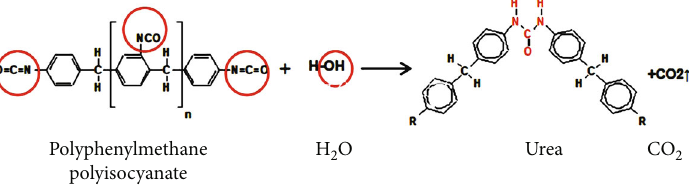
Figure 2: Principle of foaming reaction.